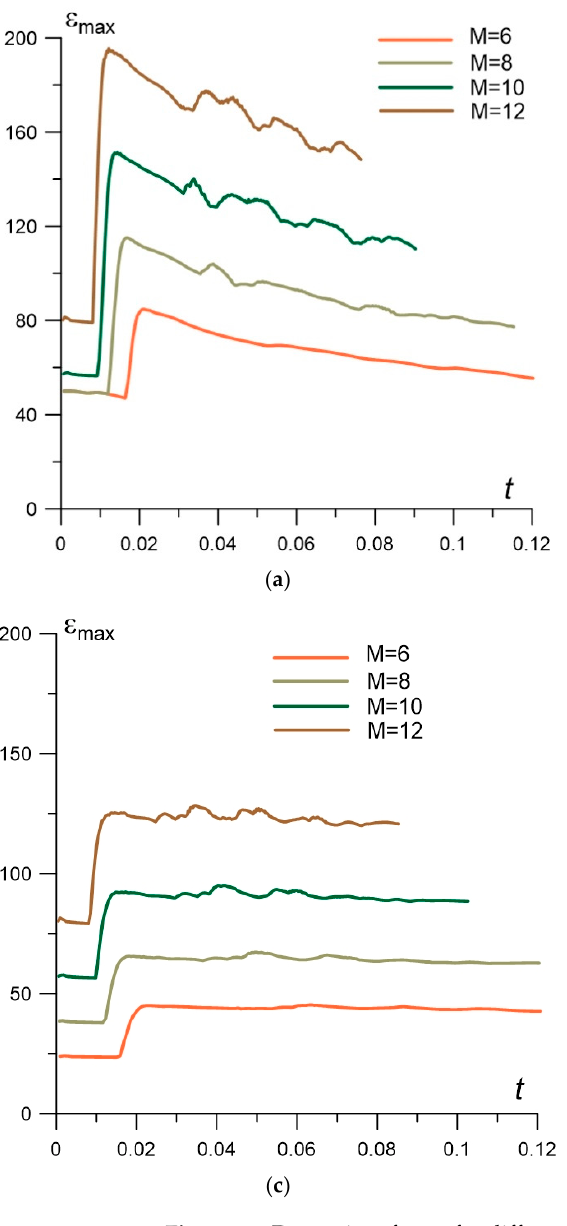
Figure 11. Dynamics of ε max for different M: ( a ) α = 0.1; ( b ) α = 0.2; ( c ) α = 0.3; ( d ) α = 0.4.